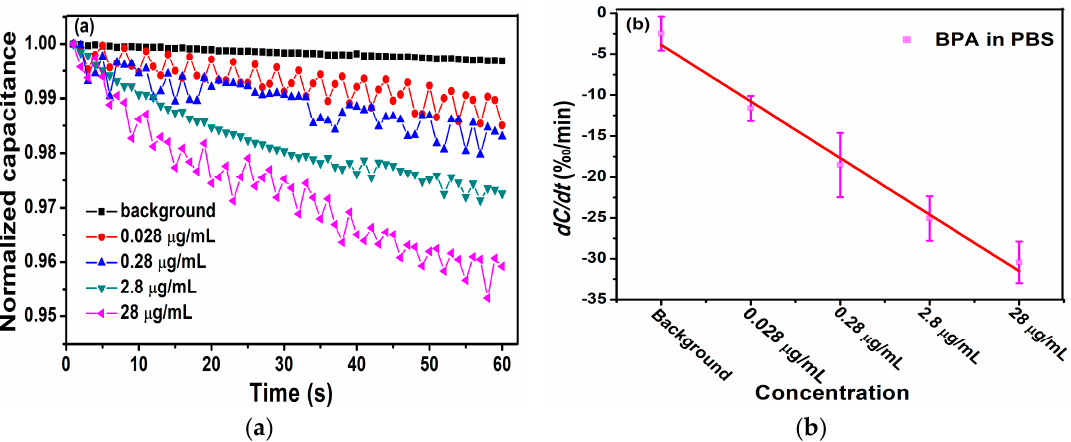
Figure 6. ( a ) Detection of different concentrations of antigen with 5.3 μ g/L antibody. ( b ) The change rate of capacitance as a function of BPA concentrations in 0.01 × PBS.